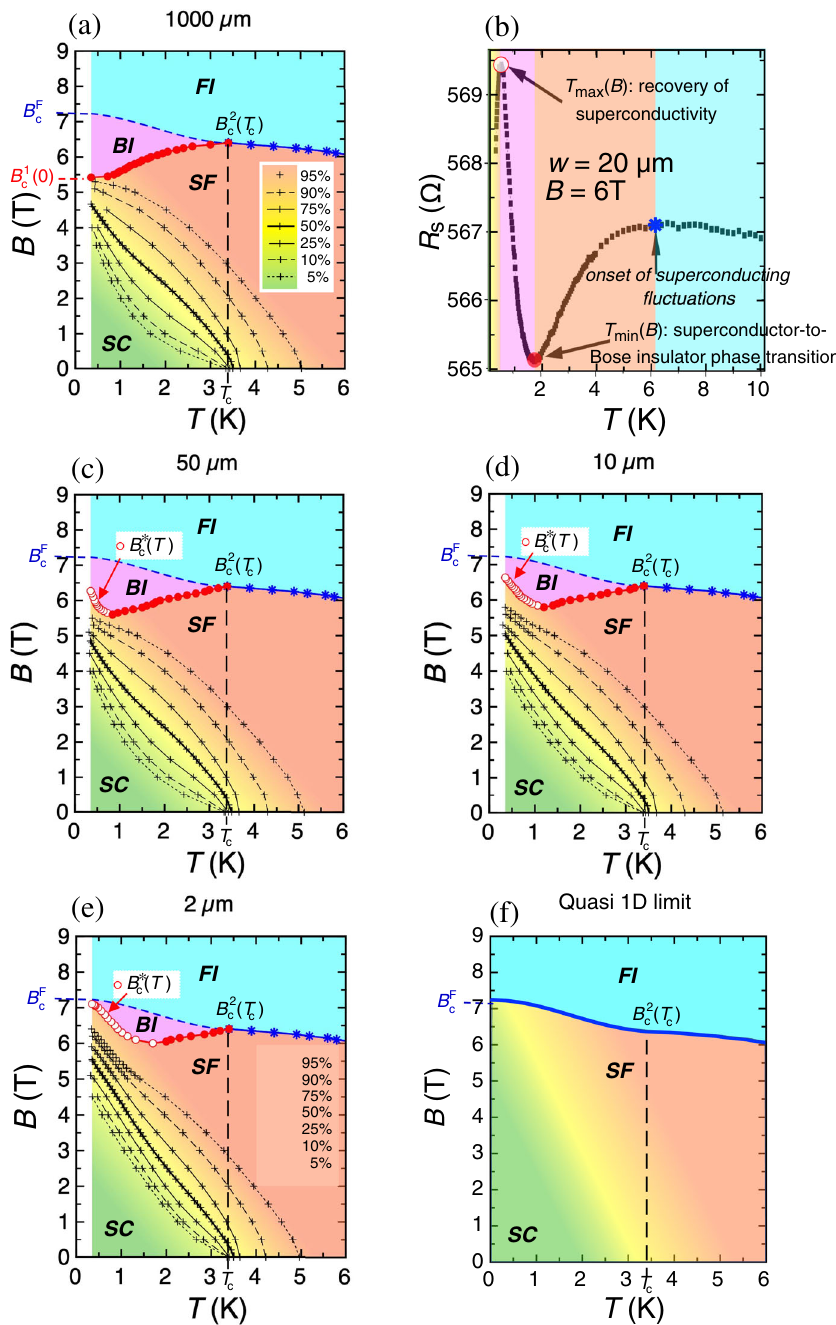
Fig. 2 The schematic magnetic fi eld B vs. temperature T phase diagrams. a Sequential superconductor (SC)-Bose insulator (BI), -Fermi insulator (FI) quantum phase transitions for in fi nite 2D superconducting systems. The lines connecting the crosses ( + ) represent the measured resistance values for fi xed fractions of the normal-state resistance from 5% to 95%, extending to the region dominated by superconducting fl uctuations (SF). b Sheet resistance R T ð Þ from 0.35 to 10 K in B = 6 T for the 20 µ m-wide bridge as an example. All relevant temperatures are marked with arrows. The coloring of the s respective phases and the symbols marking the phase transitions between them are the same as we used in the phase diagrams in Fig. 2a, c – e and in the Supplementary Figs. 5, 8, and 9. c – e Superconductor-to-insulator phase transitions for quasi-2D superconducting systems with dimensions smaller than the Pearl length Λ 0 ð Þ . The blue stars indicate the onset of the superconducting fl uctuations; the full red circles represent the temperatures T min B ð Þ in the sheet-resistance R s T ð Þ data, whereas the open red circles are determined by the respective T max B ð Þ in R s T ð Þ , signaling the recovery of superconductivity in the narrow bridges. All these de fi nitions are visualized in Fig. 2b and in the Supplementary Figs. 8 and 9. The dashed blue line ending at the Fermi insulator quantum critical fi eld B F schematically separates the Bose-insulating and the Fermi-insulating states, with a qualitatively much more pronounced c divergence of dR s = dT towards zero temperature in the former than in the latter state (see also Supplementary Figs. 8 and 9). f Expected superconductor- to-insulator phase transition for systems approaching the 1D